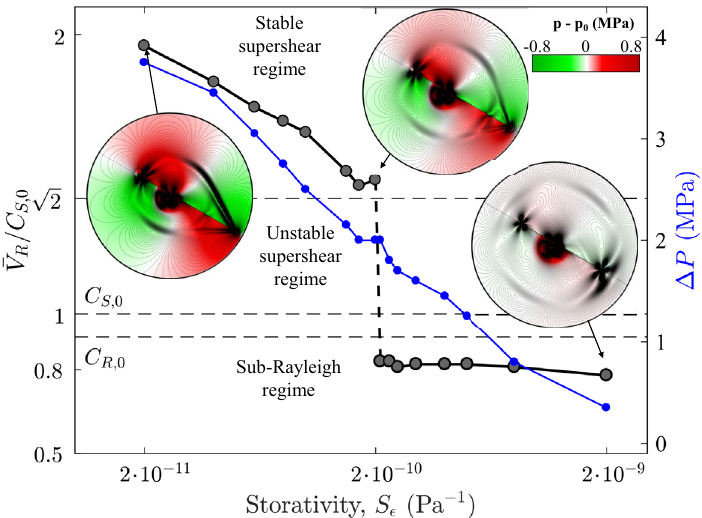
Figure 3. Effect of rock-fluid system compressibility on rupture speed. With the simulation setup of Fig. 1, we vary the specific storage coefficient, S ǫ , which controls the extent of the undrained overpressure at the detachment front, (cid:31) P . We plot the normalized rupture velocity, ¯ V R / C S ,0 (black line, left axis), and the undrained overpressure at the rupture front, (cid:31) P (blue line, right axis), against S ǫ . For rather incompressible systems (small values of S ǫ ), the overpressure is significant and the rupture is supershear. As the system storage capacity increases, thus reducing the coseismic undrained overpressure, propagation speed decreases. Beyond a threshold value of S ǫ , the rupture front velocity falls within the sub-Rayleigh range. This abrupt parametric shift is compatible with the existence of a range of unstable rupture speeds: if the fault is large enough, ruptures 0.8 C would either become asymptotically sub-Rayleigh, with ¯ V R S , or accelerate to supershear with rupture ≈ speeds larger than the Eshelby speed, √ 2 C S ,0 . The reported rupture speeds are calculated as the average during the rupture (see Supplementary Information, Section